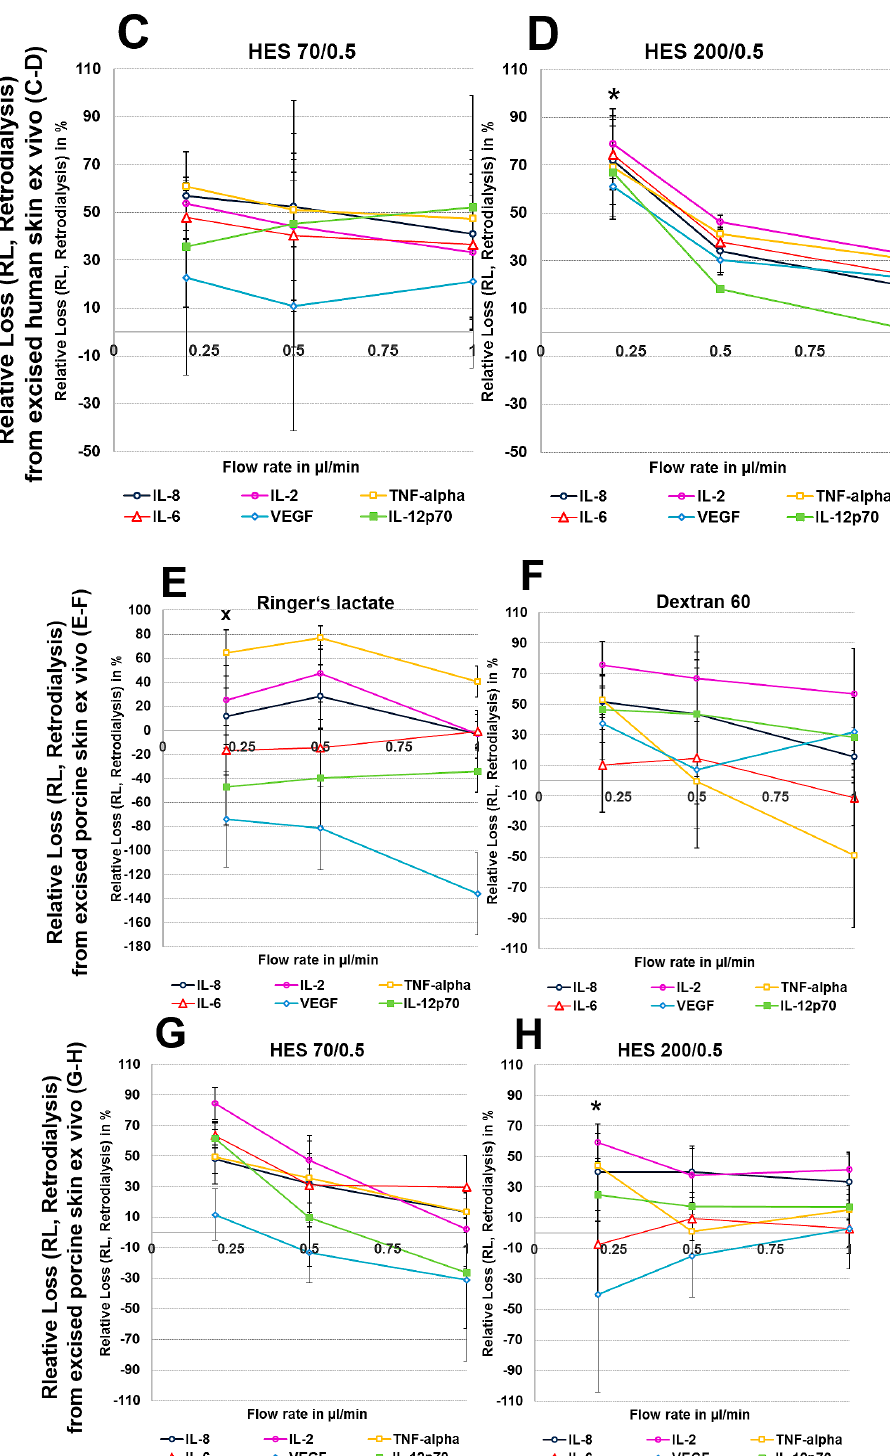
Figure 4. ( A – H ): Effect of different colloid perfusates (dextran 60 ( B , F ), hydroxyethyl starches (HES) 70/0.5 ( C , G ) and 200/0.5 ( D , H ) and the crystalloid Ringer’s lactate solution ( A , E )) on relative loss (RL) from excised human ( A – D ) and porcine skin ( E – H ) during retrodialysis and ex vivo experiments. Each figure represents the mean values with standard deviation of three independent experiments of all six different cytokines at flow rates of 0.2, 0.5 and 1 µ L/min. Significance ( p < 0.05) is indicated by *, x, o, and +. * shows significant differences compared with Ringer’s lactate, x shows significant differences compared with HES 200/0.5, + shows significant differences when compared with HES 70/0.5, and o shows significant differences compared with dextran 60